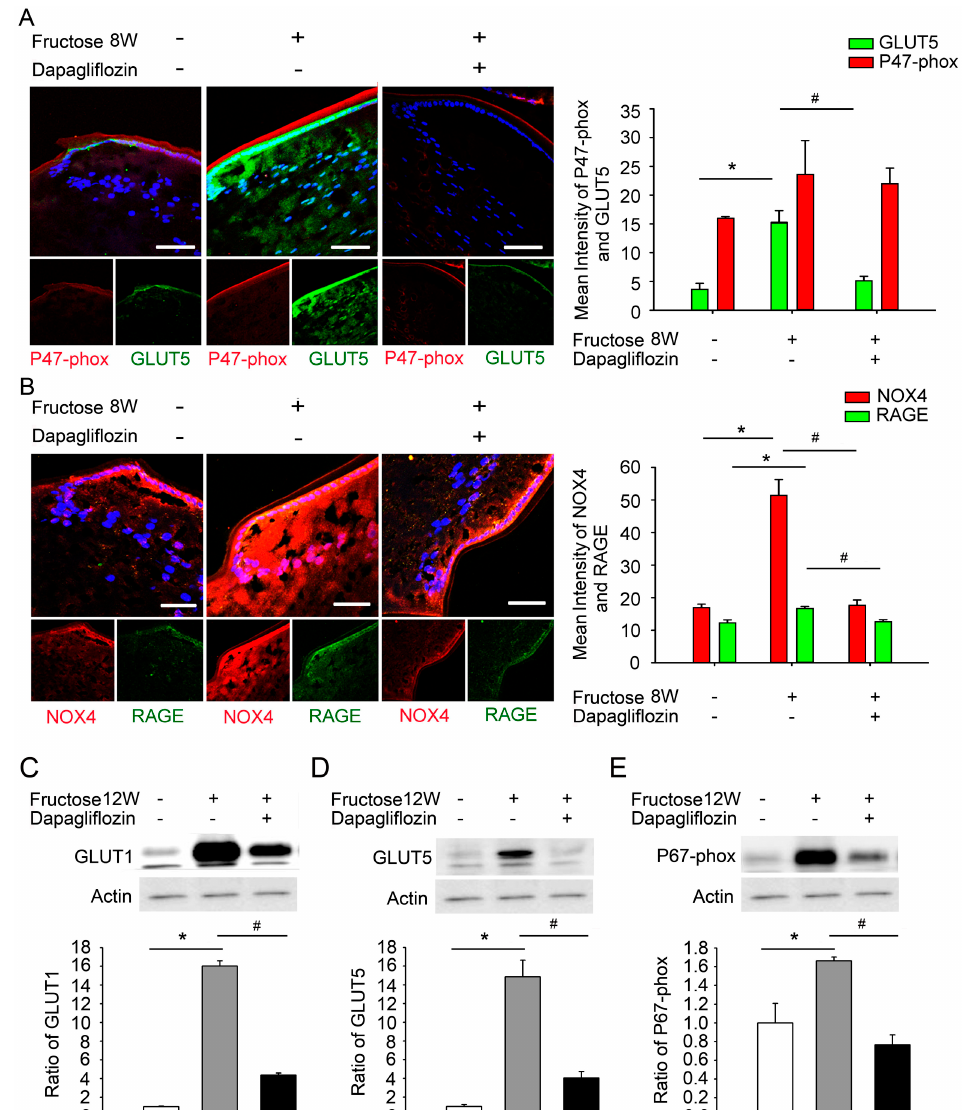
Figure 3. Dapagliflozin reduces glucose transporter (GLUT)-induced expression of the receptor for advanced glycation end products (RAGE), nicotinamide adenine dinucleotide phosphate reduced form oxidase 4 (NOX4) and nicotinamide adenine dinucleotide phosphate reduced form (NADPH) oxidase subunit (p67-phox) levels in the lenses of rats with fructose-induced type 2 diabetes mellitus (DM). ( A – B ) Representative fluorescence images of GLUT5- and RAGE-expressing cells (green) and p7-phox and NOX4-expressing cells (red) in the lens with or without a systemic administration of fructose or dapagliflozin. Cell nuclei are counterstained with DAPI (blue). ( C – E ) Quantitative immunoblotting analysis demonstrating that the GLUT1, GLUT5, and p67-phox levels in the lenses of rats with fructose-induced type 2 DM were significantly decreased by dapagliflozin administration. Values are presented as the means ± SEMs ( n = 6 per group, separate experimental groups in each figure). Scale bar: 20 µ m. * p < 0.05; # p < 0.05 vs. Fructose 8 W or 12